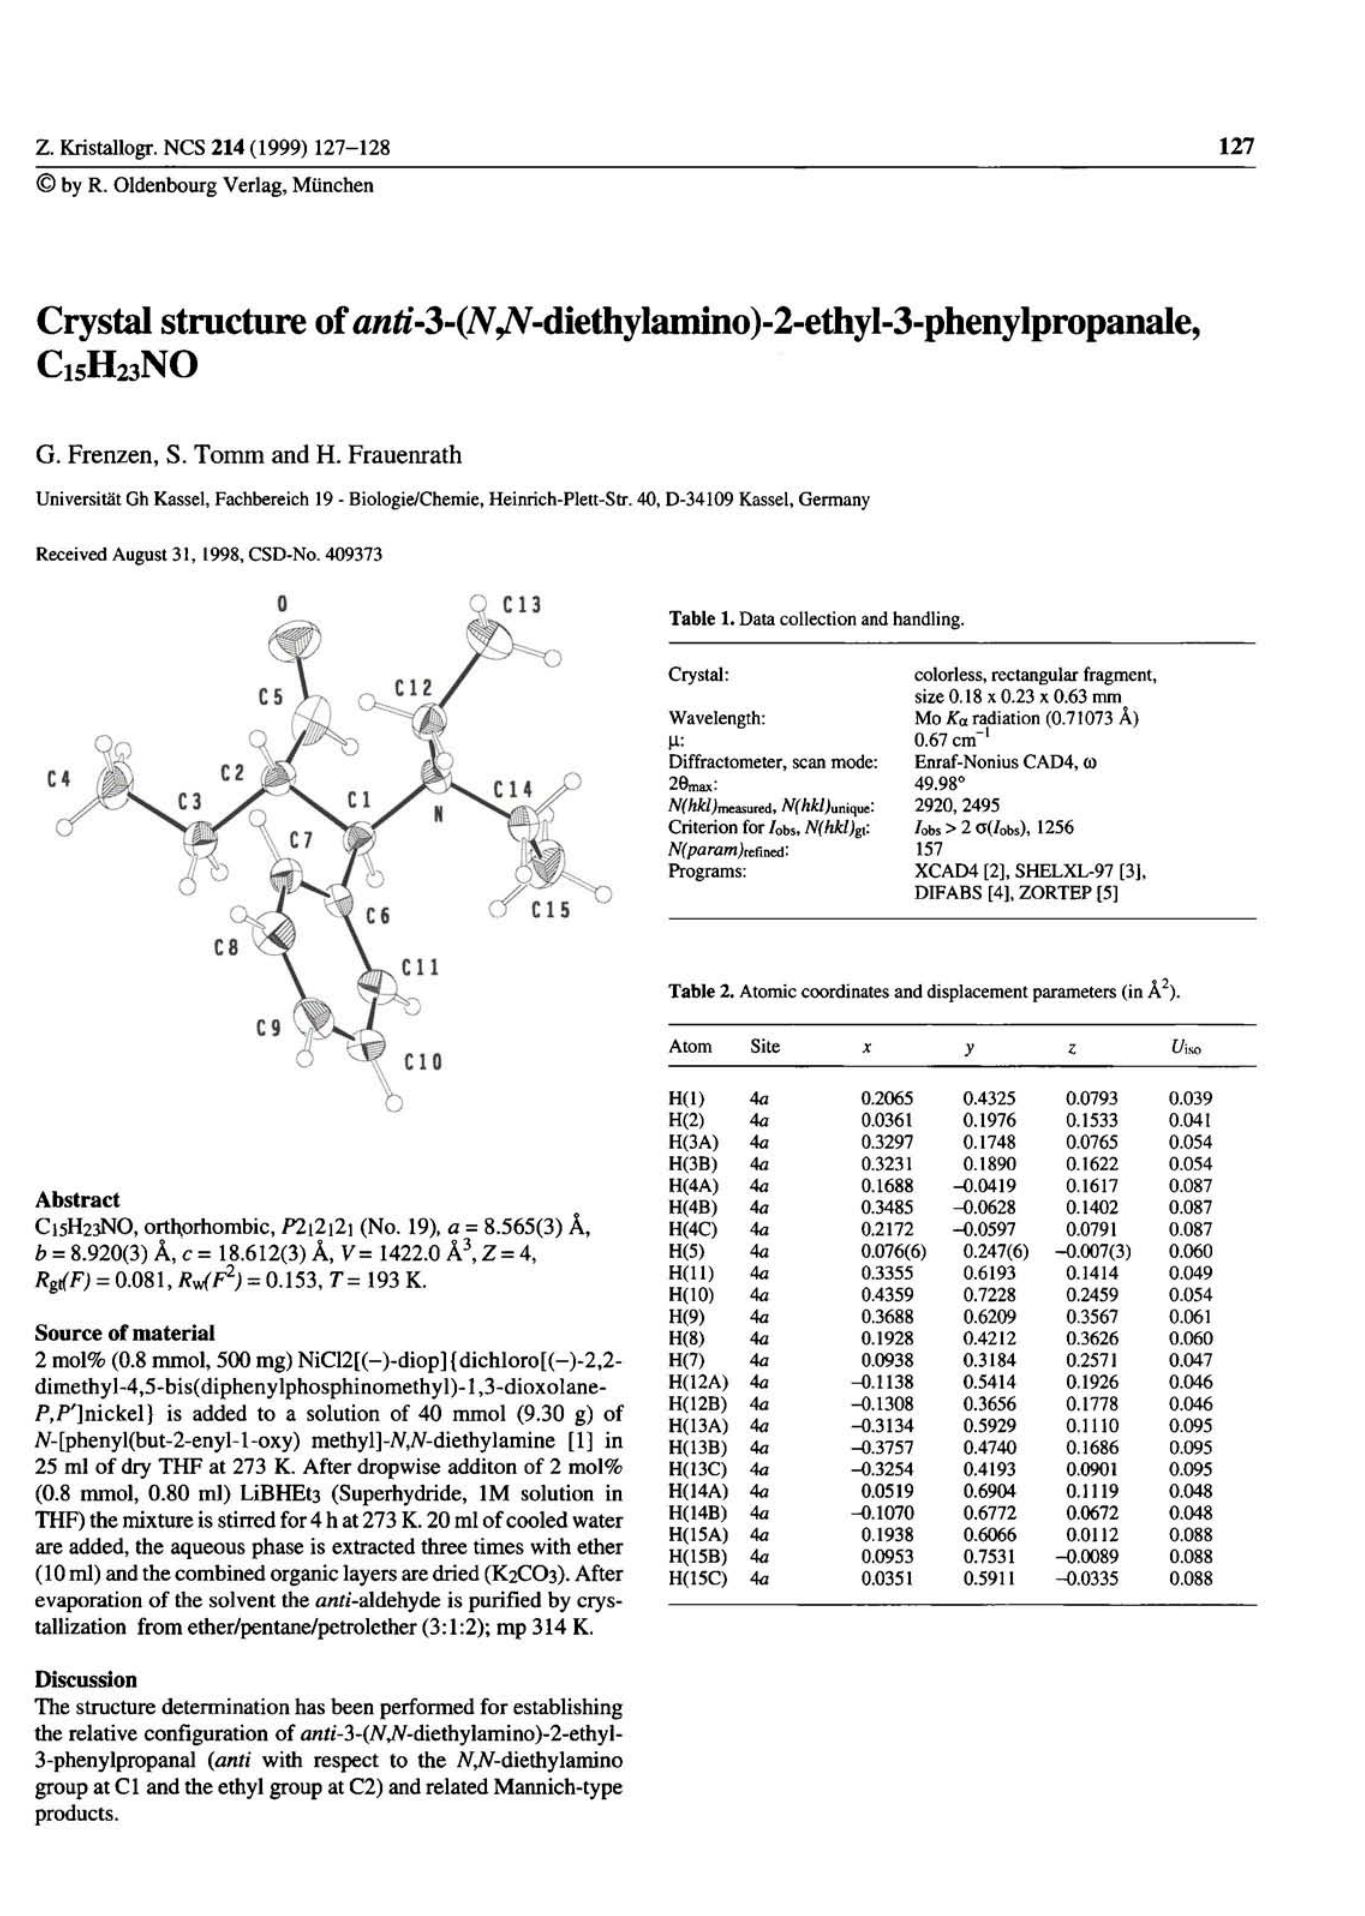
Table 2. Atomic coordinates and displacement parameters (in Â 2